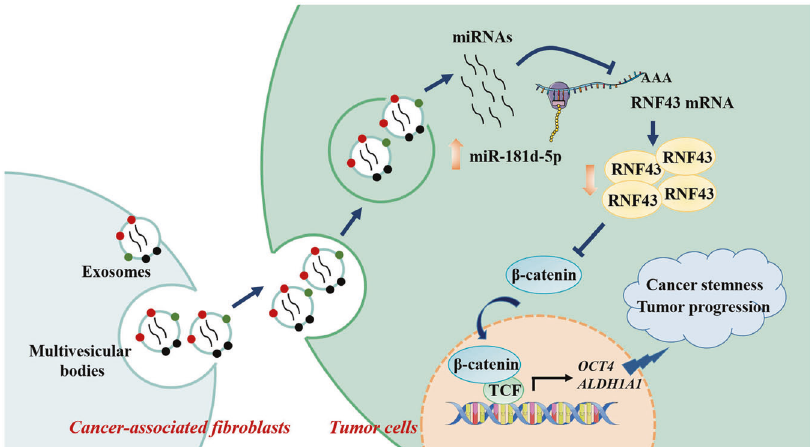
Fig. 10 A schematic diagram of the mechanism. CAFs secreted exosomal miR-181d-5p to RCC cells, suppressed the expression of RNF43, activated Wnt/ β -catenin signaling pathway, thus promoted cancer stemness and tumor